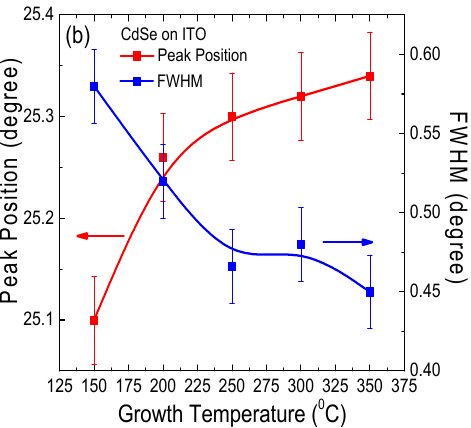
Figure 1 . ( a ) XRD patterns of the CdSe thin films showing a wurtzite phase with a peak at (002) for samples deposited at 150 °C to 350 °C, and peak (110) for the sample deposited at 400 °C. ( b ) Growth temperature dependent XRD (002) peak position and its FWHM change for the CdSe thin films. The solid lines are a guide for the eyes.